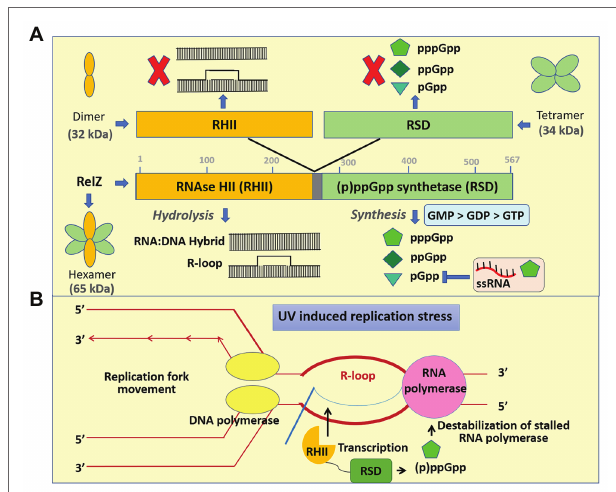
FIGURE 3 | Mechanism of regulation and functions of RelZ. (A) RelZ contains an RNAse HII (RHII) domain in tandem with the (p)ppGpp synthetase domain (RSD, RelA SpoT nucleotidyl transferase domain). Full-length protein in cis has both RNAse HII activity and (p)ppGpp synthetase activity whereas neither the purified domain variants in isolation nor on trans complementation can function independently. RelZ can hydrolyze RNA:DNA hybrid as well as R-loop. It can synthesize pGpp, ppGpp, and pppGpp having the substrate preferences as GMP > GDP > GTP. pGpp synthesis is negatively regulated by ssRNA and high concentrations of pppGpp. From our earlier studies on active site mutational analysis, gel filtration chromatography followed by native PAGE revealed that the N-terminal RHII domain is monomeric and C-terminal RSD domain is tetrameric upon isolation. The full-length active protein is, however, hexamer in solution. We also found that RelZ and all the mutant variants of the full-length RelZ remain as hexameric form in solution. (B) In our previous study, we demonstrated that RelZ can hydrolyze R-loops in Escherichia coli exposed to UV stress. RelZ gene expression was upregulated under UV stress, and this gene-deleted strain showed increased R-loop accumulation as compared to the wild type. Based on these results, we proposed a model for the physiological function of RelZ. UV stress leads to increased R-loop formation and replication–transcription conflicts. Under UV stress, RelZ expression is upregulated than the conventional RNase HI and HII. Its RHII activity removes the R-loops and the stalled RNA polymerase is destabilized indirectly by (p)ppGpp. Thus, RelZ plays an important role during R-loop- induced replication stress response in Mycobacterium smegmatis . (B) is adapted and redrawn from Krishnan et al.